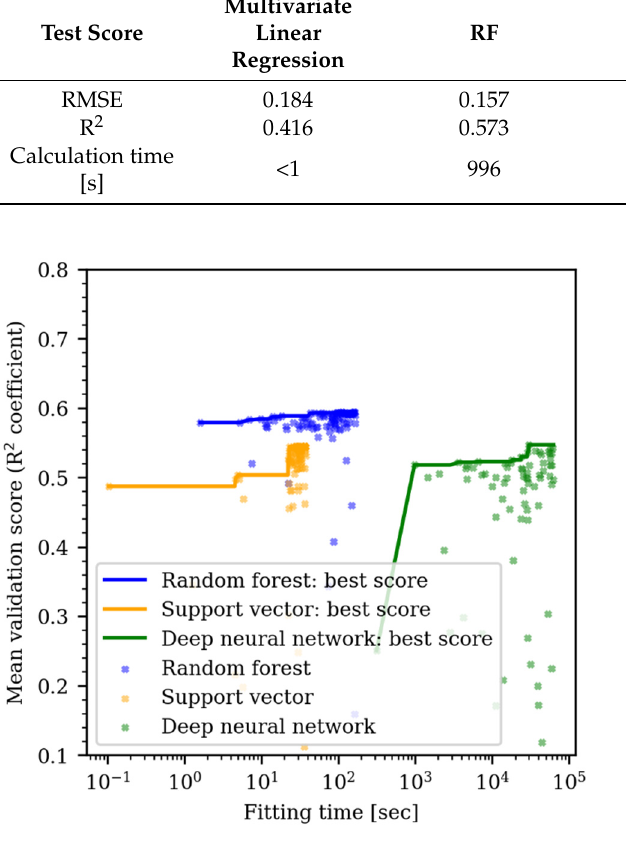
Figure 8. Mean validation score and required fitting time for three machine learning algorithms. Table 7. Test scores and calculation times for three machine learning algorithms.